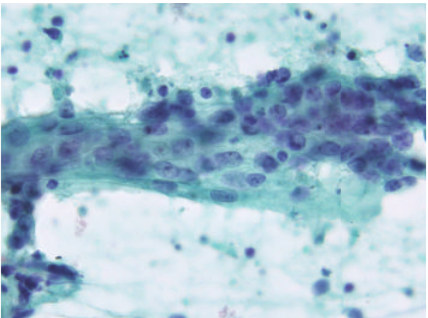
Figure 2: Papanicolaou-stained smear showing loosely cohesive clusters and stratification. The main cells exhibited scant cytoplasm and an indistinct cell border, forming loosely cohesive clusters (right side) that were in contact with foci of stratification (center-left side), which consisted of occasional cells with a clear cell border and moderately delicate cytoplasm.